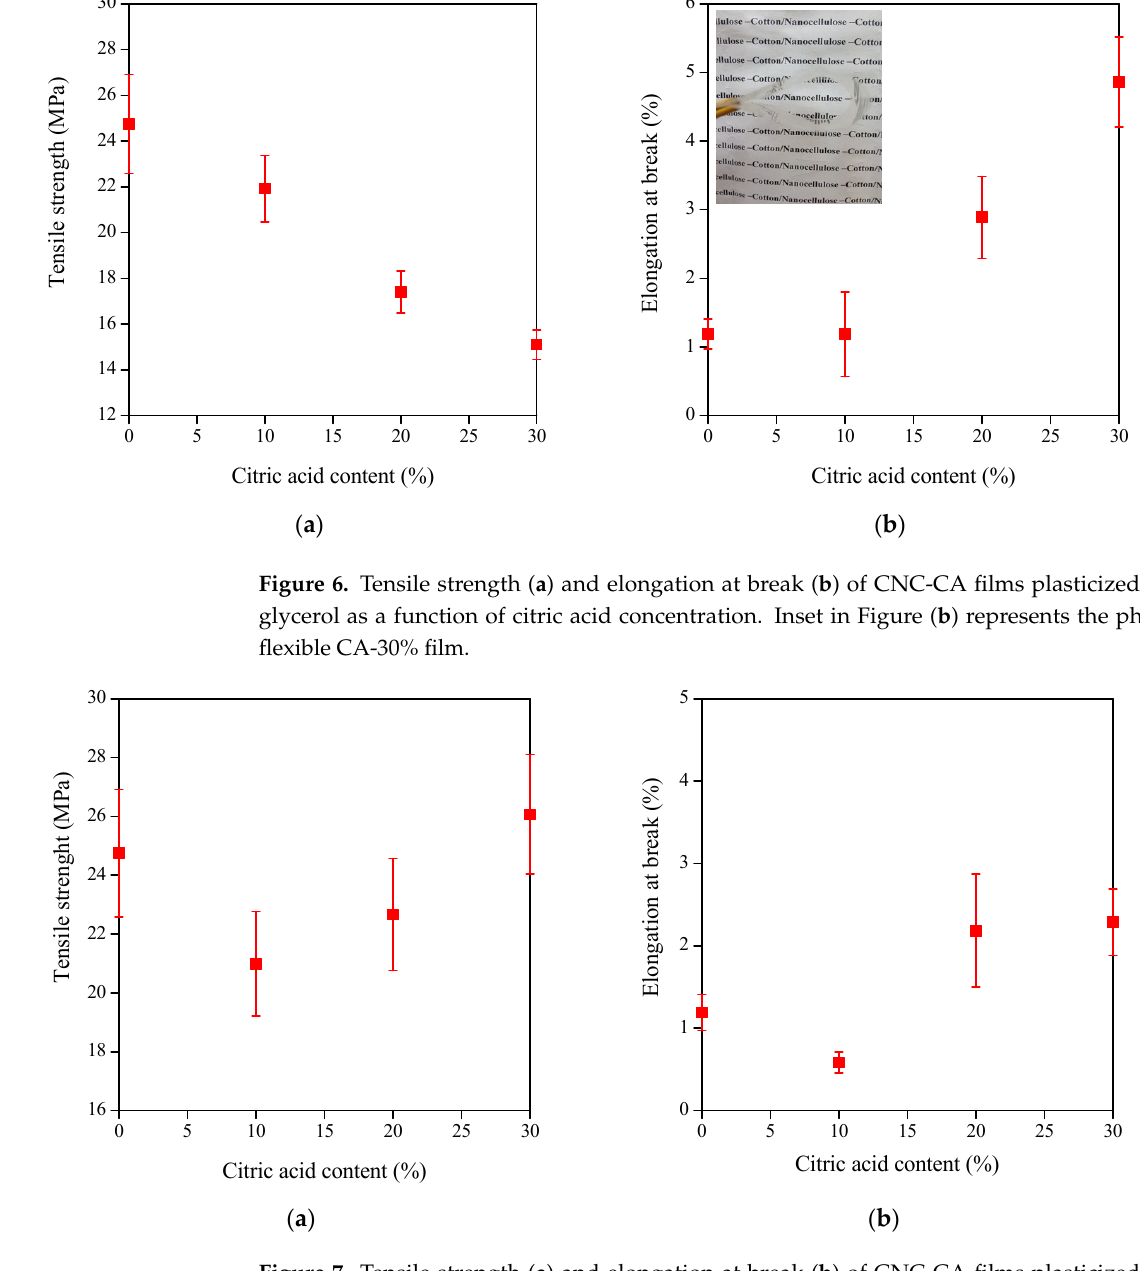
[15]. Increased tensile strength was also measured for citric acid–starch–cellulose foams up to a citric acid concentration of 5%. Above 5%, however, a decrease in tensile strength